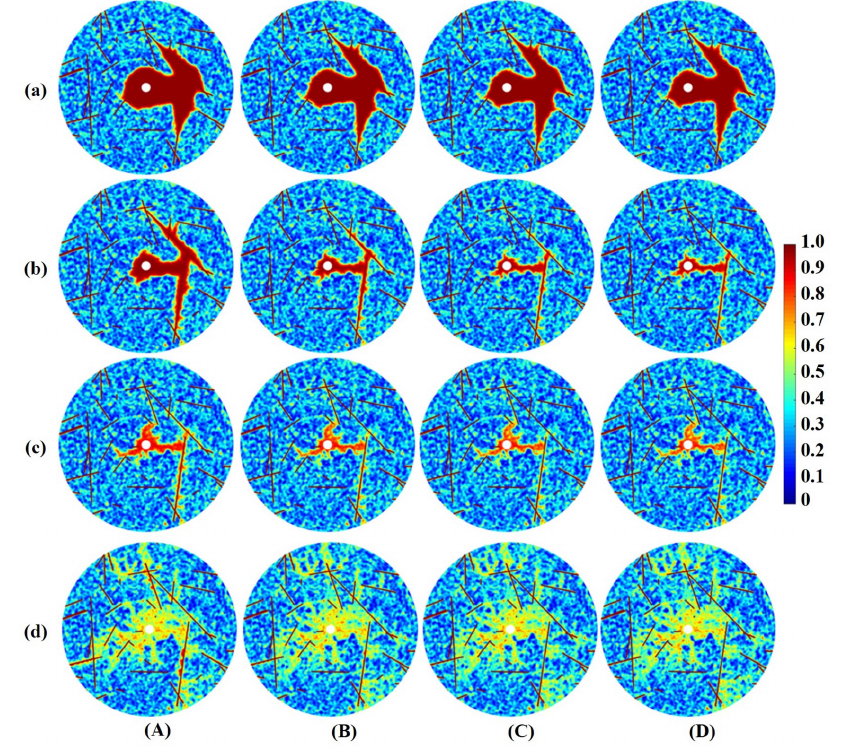
Figure 11. Comparison of dissolution structures at different effective stress: ( A ) σ = 0 MPa, ( B ) σ = 15 MPa, ( C ) σ = 30 MPa, ( D ) σ = 45 MPa and at different injection rates: 1/ Da = ( a ) 0.00075, ( b ) 0.0225, ( c ) 0.075, ( d )